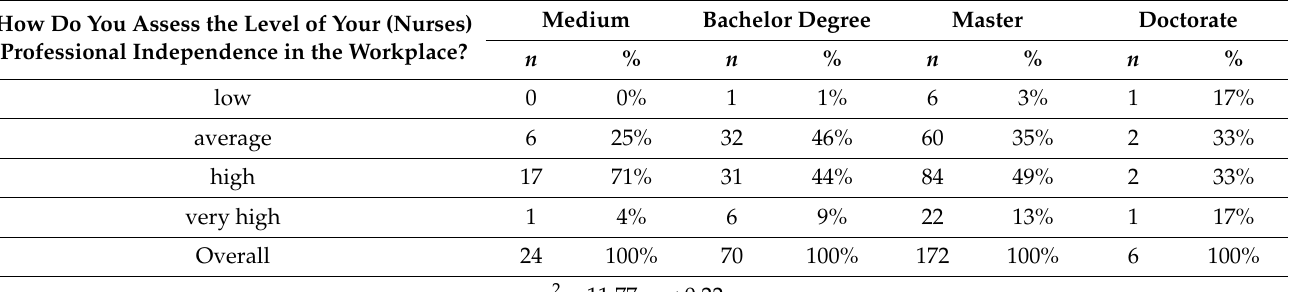
Table 3. Characteristics of the assessment of professional independence in the workplace in the education group.